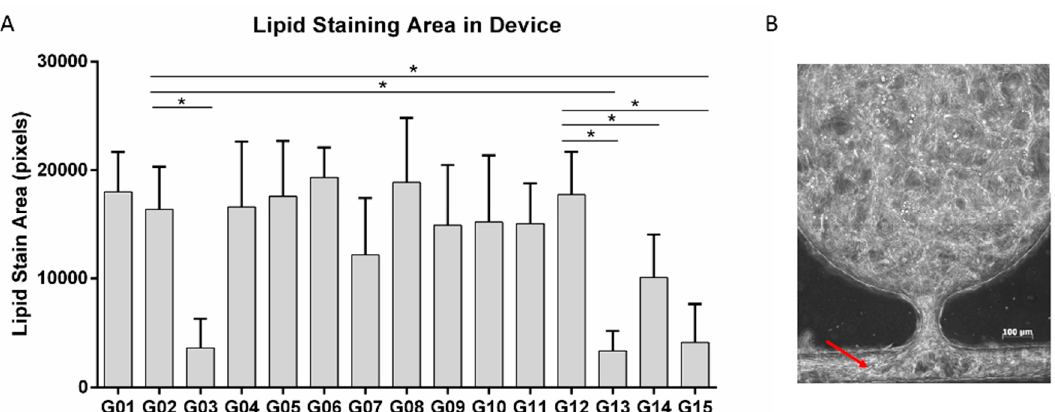
Figure 7. BODIPY staining of differentiated ADSCs in tissue on a chip in the presence of various culture supplements. ( A ) Quantification of lipid staining in the different groups. ( B ) An example of cells migrating into and blocking the side channels (red arrow). For all datasets, the values are mean